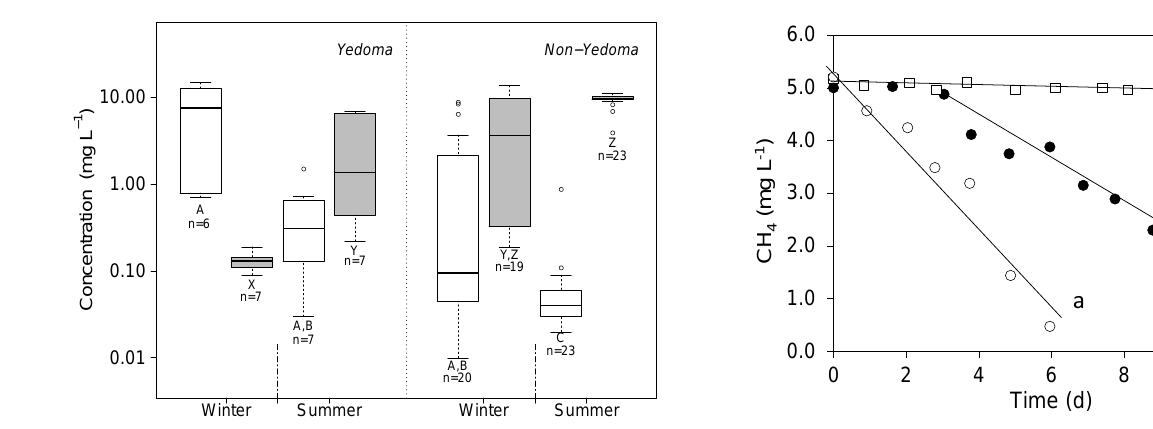
Figure 3. Statistical distributions of CH 4 (white boxes) and DO (grey boxes) water concentrations in yedoma and non-yedoma lakes during the winter and summer. The boxes include the me- dian (Q2) and the quartile range (Q1 and Q3). The whiskers show minimum and maximum data. The open circles show outlier data. Capital letters are Kruskal-Wallis multiple comparison test; values with the same capital letter are not significantly different ( p <0.05, Z >1.96). n represents the number of lakes measured.